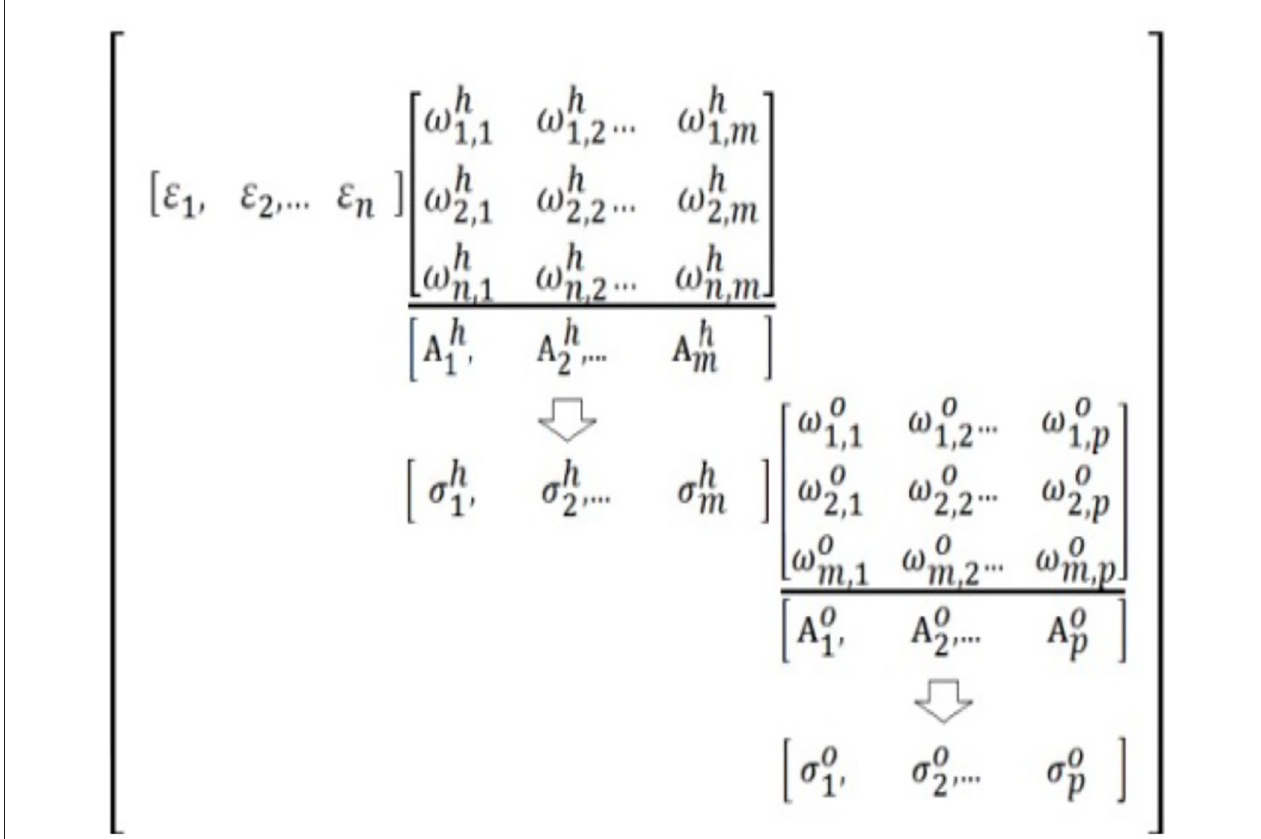
FIGURE 1 | Trained single-layer Artificial Neural Network (ANN) of low complexity to solve Tailored to the Problem Specificity Mathematical Transform (TPS MT)